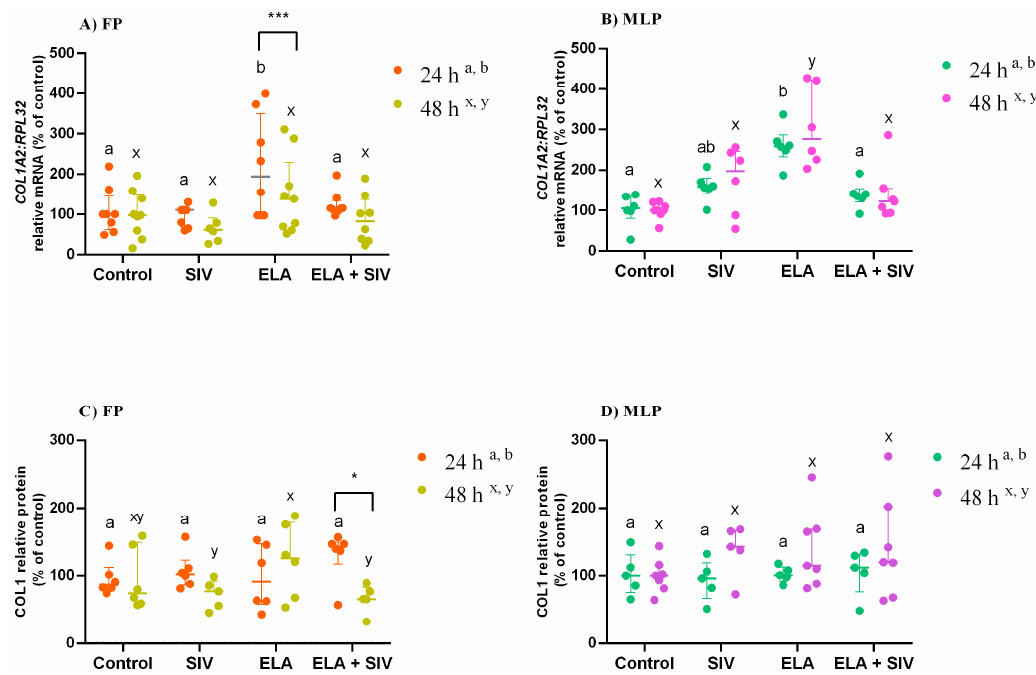
Figure 1. Relative collagen type I ( COL1A2 ) mRNA transcription ( A , B ) and protein (COL1) relative abundance ( C , D ) in follicular phase (FP) and mid-luteal phase (MLP) mare endometrial explants treated for 24 or 48 h with medium alone (control), elastase (ELA: 0.5 µg/mL), sivelestat (SIV: 10 µg/mL), or ELA (0.5 µg/mL) + SIV (10 µg/mL). Data are shown as median with interquartile range. Results were considered significant at p < 0.05. Different superscript letters indicate significant differences between treatments within each treatment time (a,b—24 h; x,y—48 h). Asterisks indicate statistical differences between times of treatment for the same treatment (* p < 0.05; *** p < 0.001).